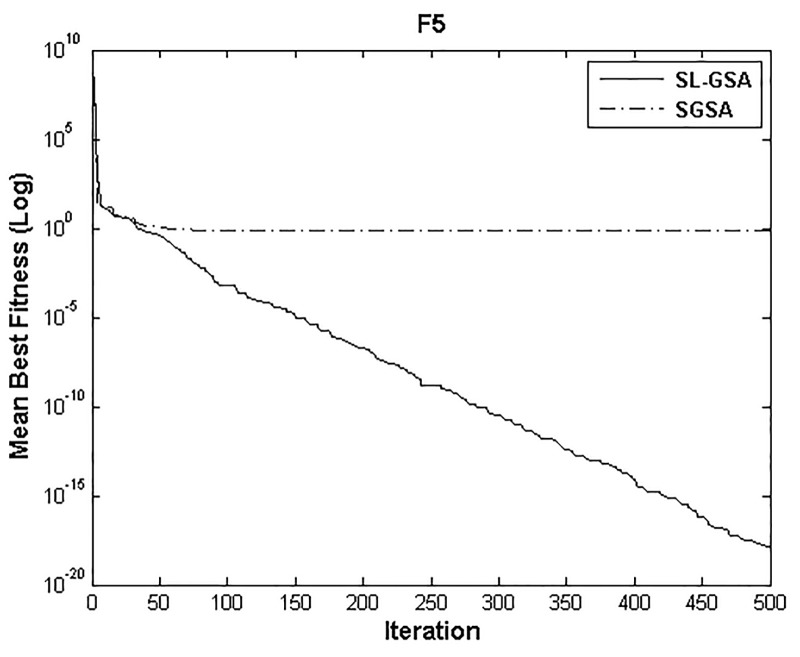
Performance comparison of SGSA and SL-GSA for minimization of F5.